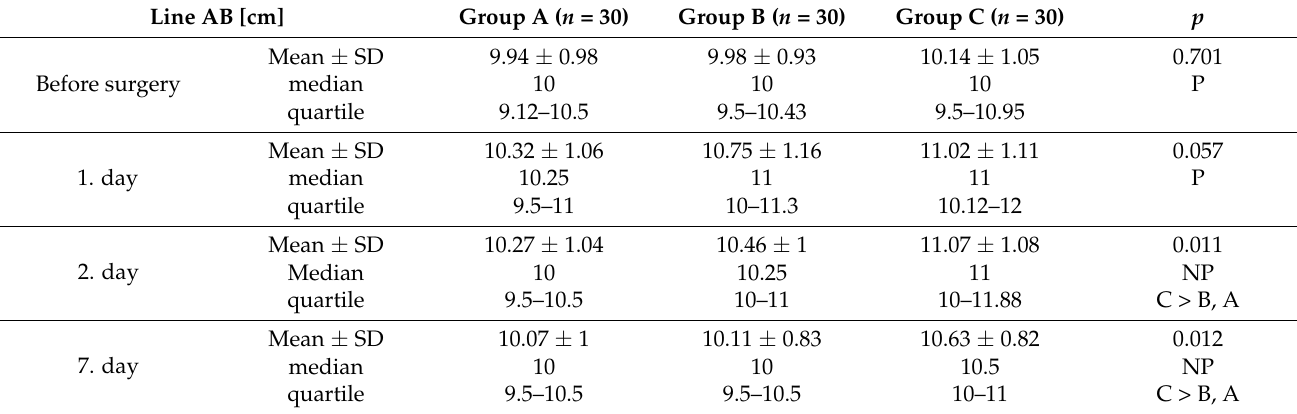
Table 5. Comparative analysis of AB line length before treatment and on day 1, 2, and 7 after treatment between groups A, B,